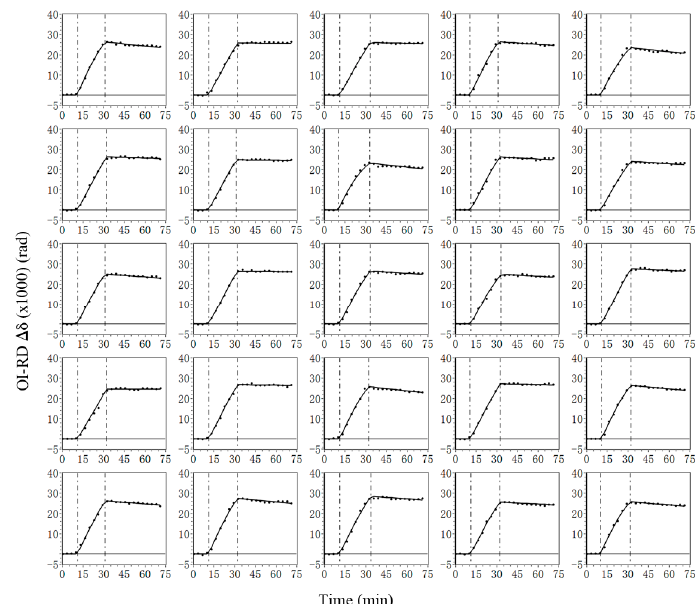
Figure 6. Twenty-five out of 5936 simultaneously acquired association-dissociation curves (solid circles) during incubation of the BBSA microarray in a solution of anti-biotin antibody. Vertical lines mark starts of association and dissociation phases, respectively. Solid lines through data points are fit to a 1-to-1 Langmuir reaction model.